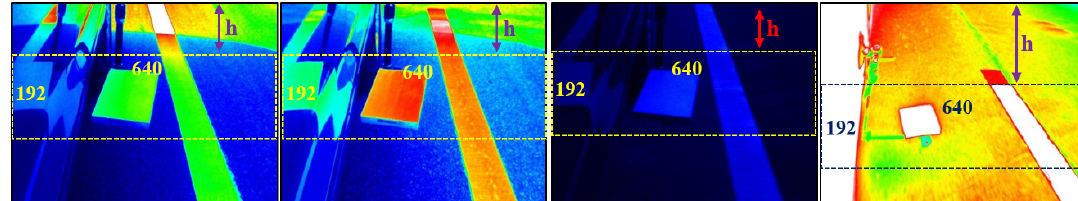
Figure 5. Examples of cropped positive images that captured the longitudinal road marking in close proximity to the reference